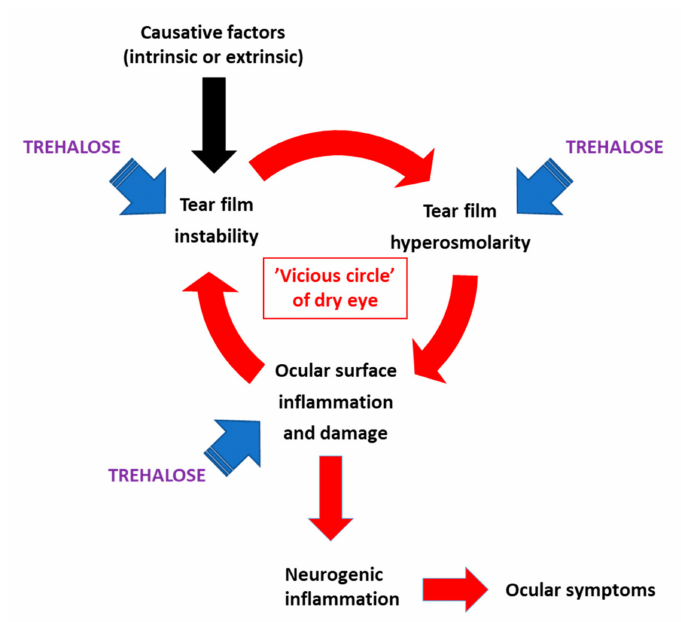
Figure 3. Etiologic factors of dry eye a ff ected by trehalose as demonstrated in clinical data. Redrawn from ref. [61], Figure S1, with permission from the